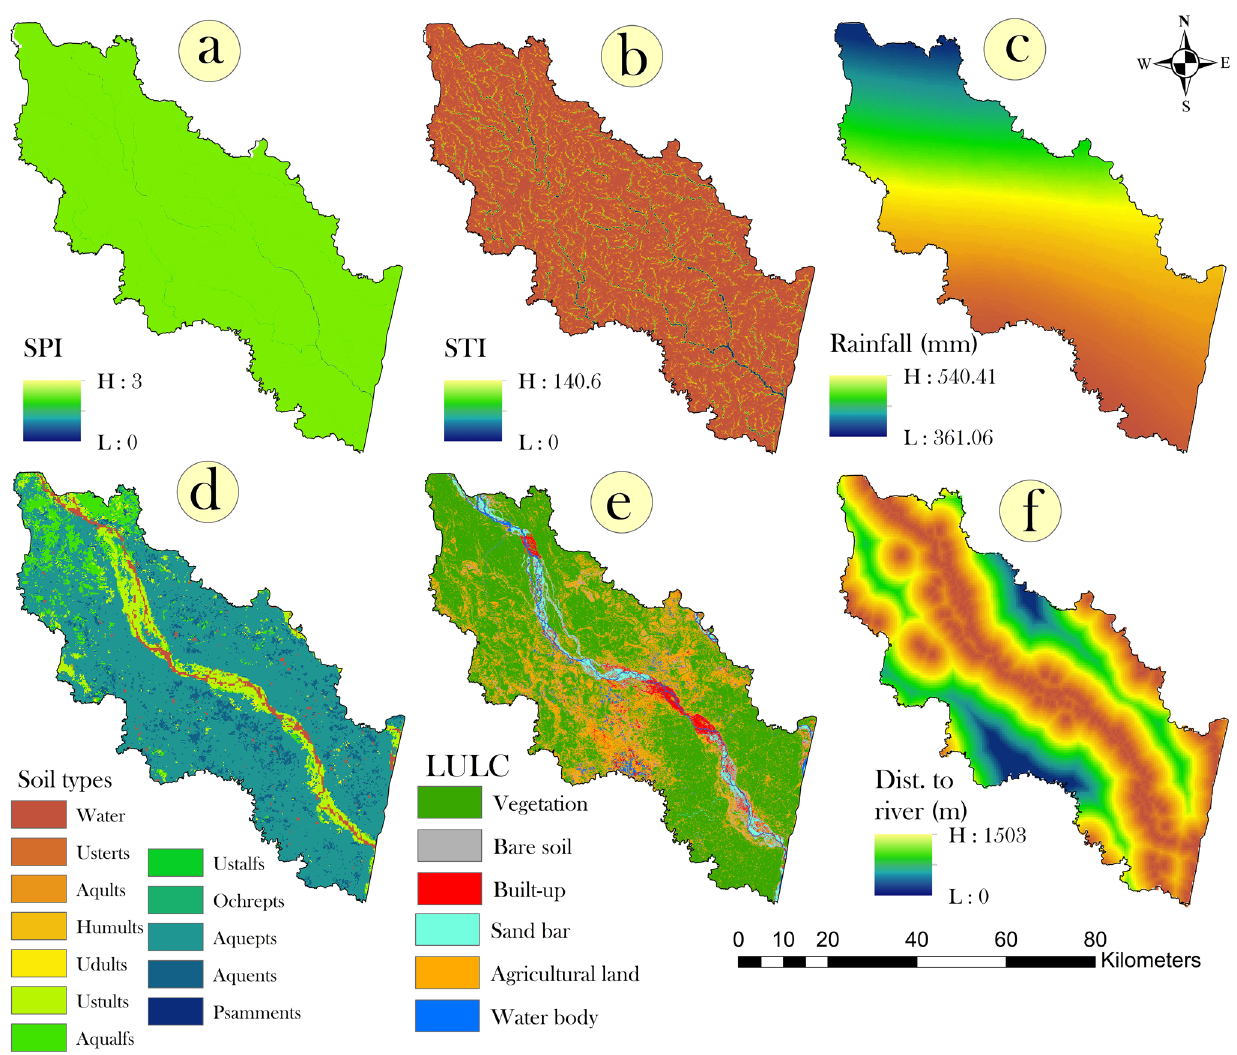
Fig. 3 Thematic layers for GWP conditioning variables such as a SPI, b STI, c rainfall d soil types, e LULC, and f distance to